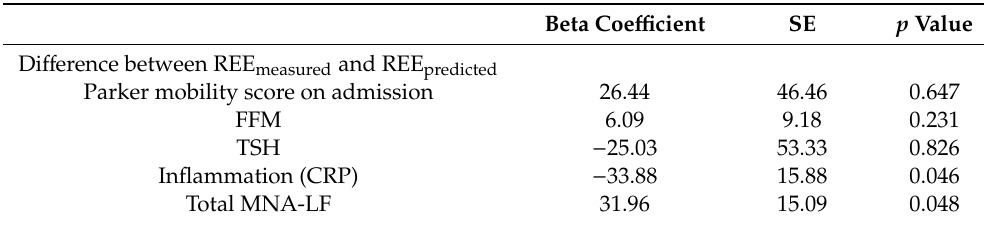
Table 3. Stepwise multiple regression analysis of risk factors associated with the di ff erence between REE measured and REE predicted. Beta Coe ffi cient SE p Value Di ff erence between REE measured and REE predicted Parker mobility score on admission 26.44 FFM TSH − 25.03 Inflammation (CRP) − 33.88 Total MNA-LF